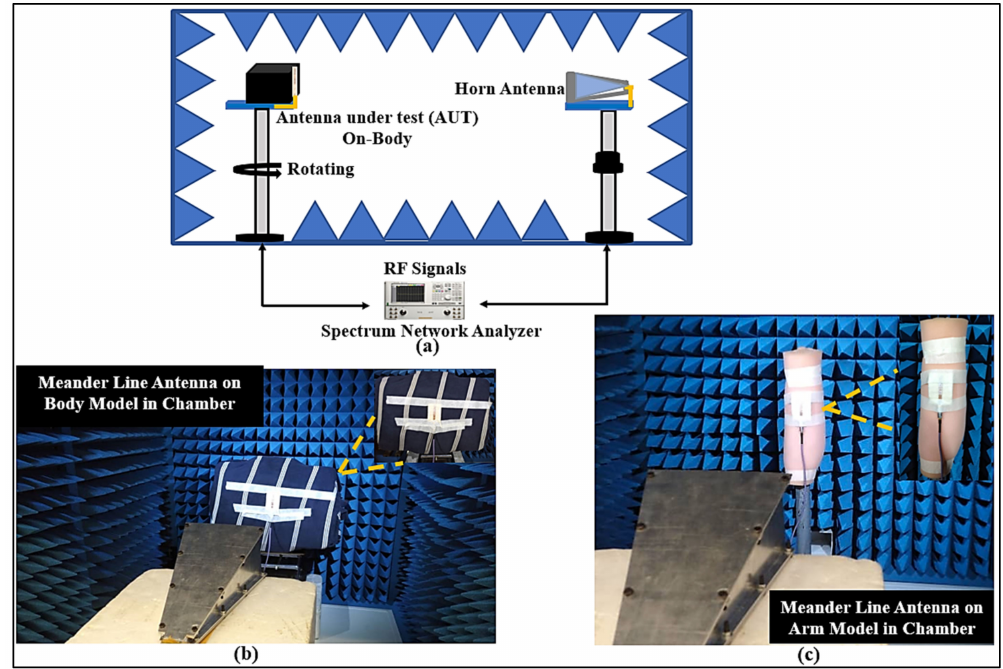
Figure 9. ( a ) Setup for the 3D far-field measurement for meander line antenna in the anechoic chamber, ( b ) human chest model, and ( c ) human arm